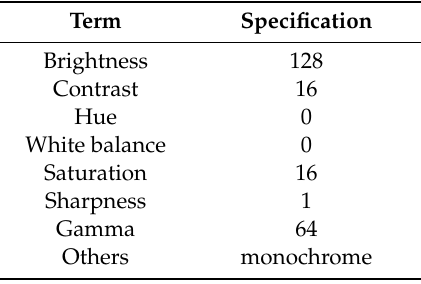
Table 2. Detailed camera settings of Dino Capture 2.0. In order to stabilize the image, we utilized the monochrome